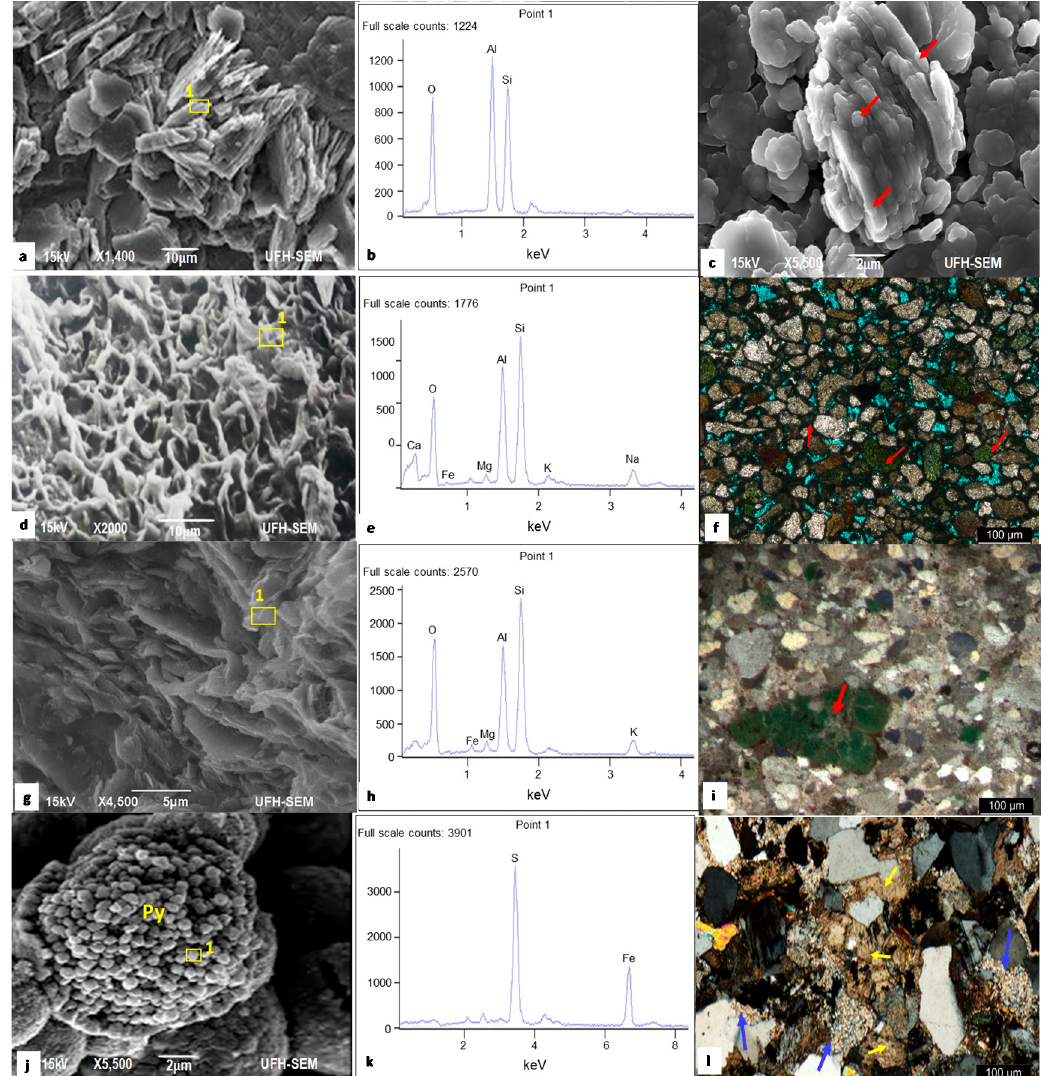
Figure 4. ( a ) SEM image showing aggregates of booklet-like kaolinite (yellow arrows) in sandstone from Borehole E-AH1 (yellow arrows); ( b ) EDX spectrum showing elemental compositions of kaolinite at point 1 in Figure 4a; ( c ) SEM image showing rod-shaped illite growth (red arrows) from the kaolinite in sandstone from Borehole E-AH1; ( d ) SEM image showing honey-comb shaped smectite in sandstone from Borehole E-BB1; ( e ) EDX spectrum showing elemental compositions of smectite at point 1 in Figure 4d; ( f ) Photomicrograph of sandstone from borehole E-AJ1 showing precipitation of glauconite in intergranular pore spaces (red arrows); ( g ) SEM image showing authigenic illite with incipient lath-like or fibrous forms in sandstone from Borehole E-BA1; ( h ) EDX spectrum showing elemental compositions of illite at point 1 in Figure 4g. ( i ) Partial replacement of feldspar and matrix by glauconite (red arrow); ( j ) SEM image of authigenic framboid pyrite in sandstone from Borehole E-BB1; ( k ) EDX spectrum showing elemental composition of pyrite at point 1 in Figure 4j; ( l ) Photomicrograph showing partial replacement of feldspar by clay minerals (red arrows) and calcite (yellow arrows).